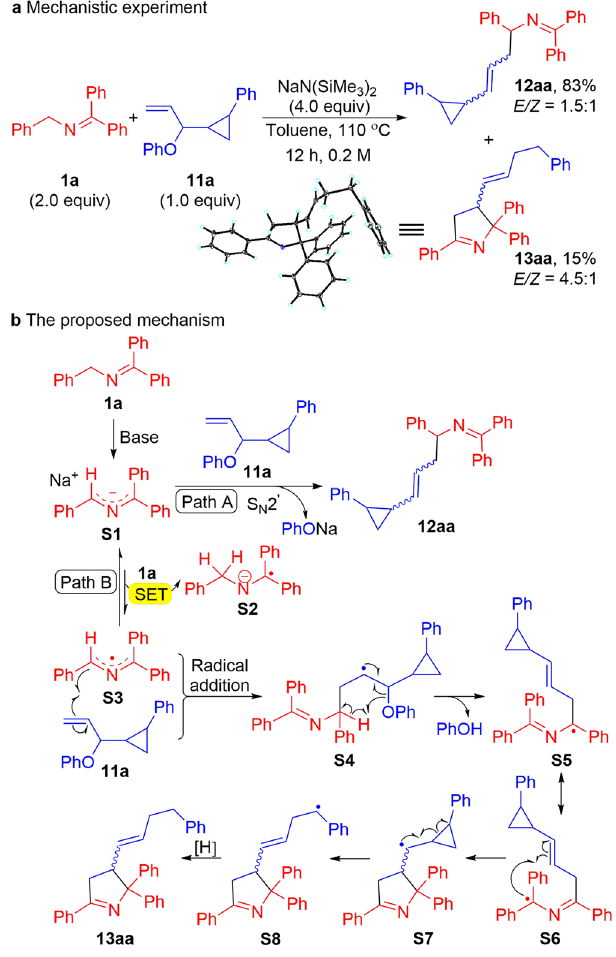
Fig. 8 Mechanistic studies. a Reaction of radical clock 11a with in situ generated 2-azaallyl anion. b The proposed mechanism for the formation of 13aa . SET, single electron